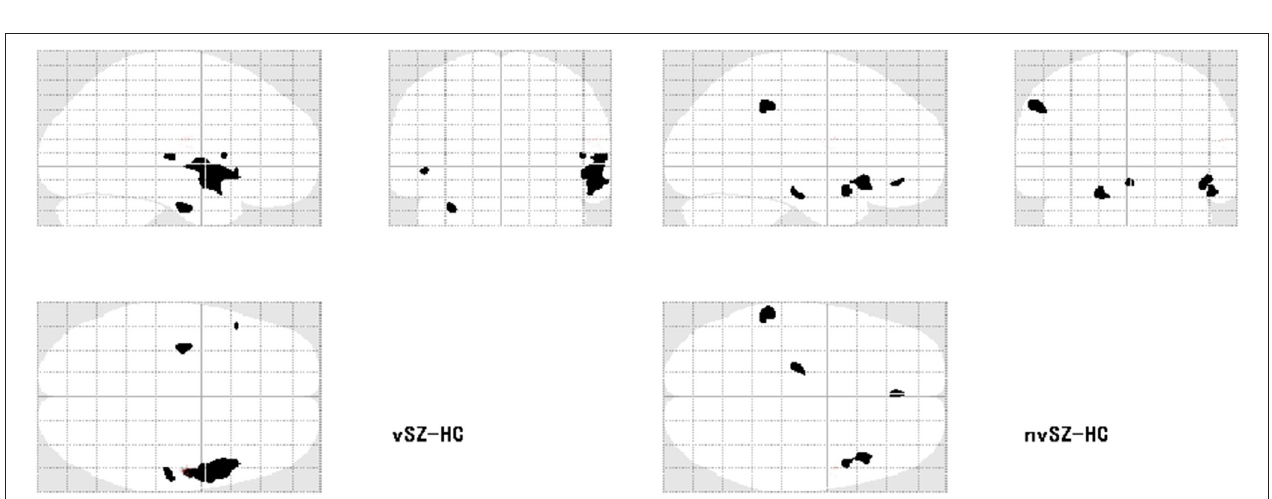
FIGURE 3 | Regions showing reduced gray matter volume in the vSZ and nvSZ groups compared to HCs on the transparent